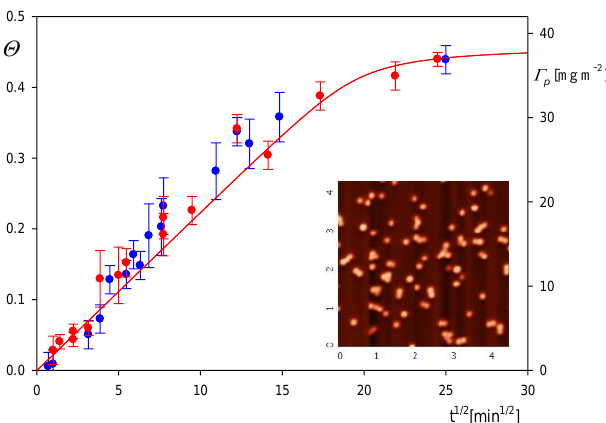
Figure 9. Kinetics of the polymer particle with HSA corona deposition on bare mica under diffusion conditions shown as the dependence of the absolute coverage Θ (left-hand axis) or the mass coverage Γ (right-hand axis) on the square root of the deposition time t 1/2 [min 1/2 ]: the corona coverage p 0.80 mg m − 2 , pH 4, 10 mM NaCl, particle bulk concentration 100 mg L − 1 . The red points show experimental results obtained by AFM imaging of particles. The inset shows the AFM image of the particle with the HSA corona layer of mica. The blue points show the reference results obtained for the positively charged polymer particles. The solid red line shows the theoretical results derived from the random sequential adsorption (RSA) model.